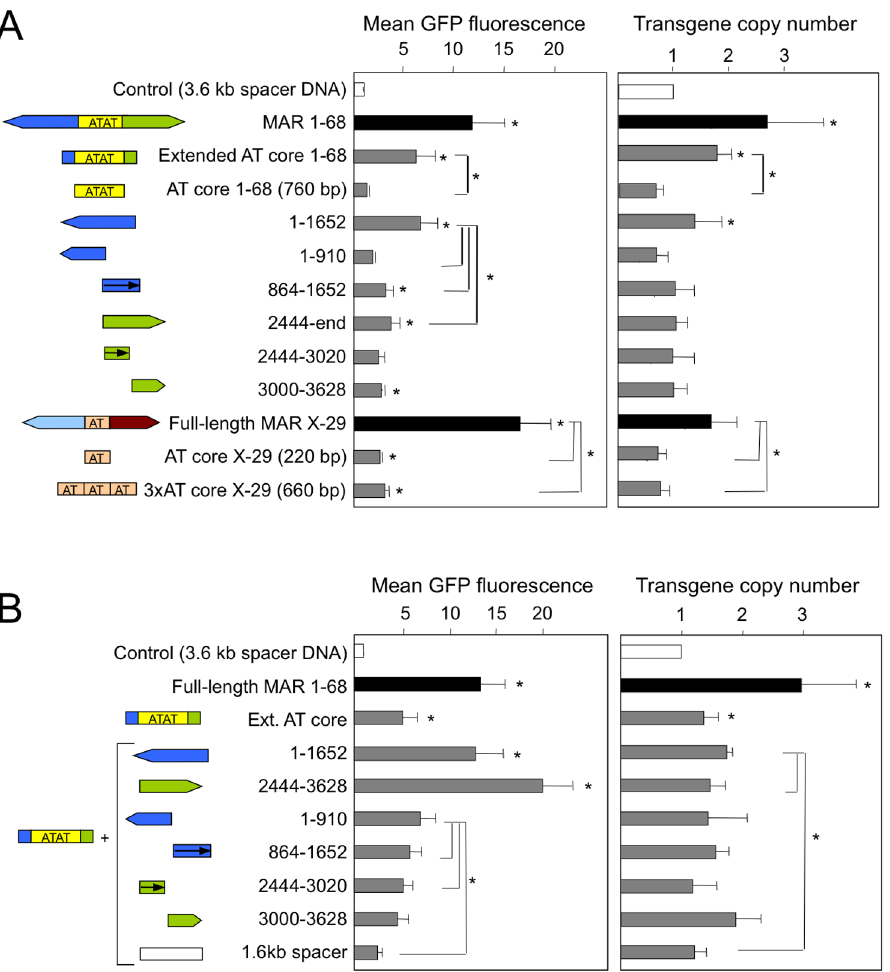
Figure 4. Effect of human MAR 1–68 and X-29 and derivatives on GFP expression and transgene copy number. (A) The mean GFP fluorescence and transgene copy numbers were determined from polyclonal cell pools generated using the illustrated constructs as described in the legend to Fig. 2. The relative GFP transgene copy number was determined by quantitative PCR using total genomic DNA isolated from transfected cell pools, and values were normalized to those of the GAPDH cellular gene. GFP expression levels and transgene copy numbers are expressed as the fold change relative to those obtained from control cells transfected with construct containing 3.6 kb of spacer DNA instead of the MAR, which was set to 1. Results represent the mean 6 SD of 3 independent experiments. Significant differences relative to the corresponding control construct containing spacer DNA of the same size, as illustrated in Suppl. Fig. S5, are indicated by stars above each bar, whereas line-associated stars indicate significant differences between the indicated constructs (Student test, P ,